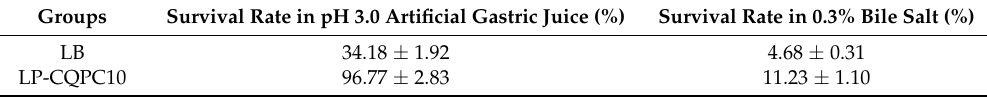
Table 2. Abilities of stanins to resist artificial gastric acid and bile salt.